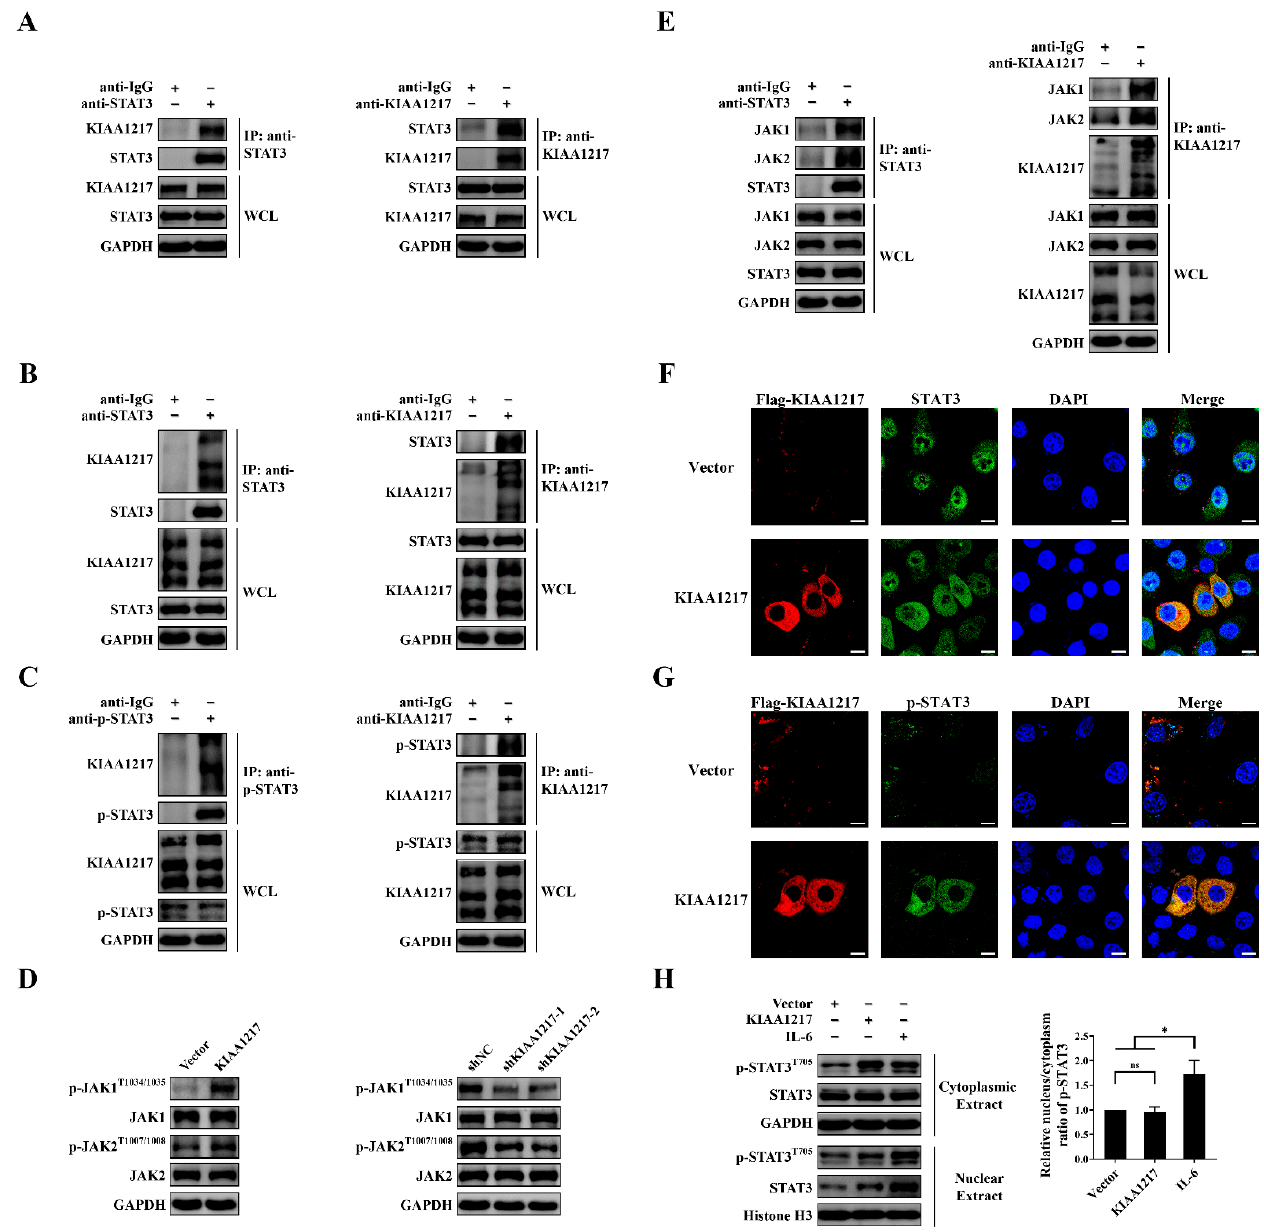
Figure 7. The interaction of KIAA1217 with STAT3/p-STAT3 and JAK1/2 in HCC cells. ( A – C ) Co-IP analysis of KIAA1217 and STAT3/p-STAT3 in HEK-293T cells ectopically expressing KIAA1217 and STAT3 ( A ) or in HepG2 cells ( B , C ). Isotype-matched IgG was used as a negative control. ( D ) Western blot analysis of the levels of JAK1/2 and p-JAK1/2 in HepG2 cells with KIAA1217 overexpression or knockdown. ( E ) Co-IP analysis of JAK1/2 with KIAA1217 or STAT3 in HepG2 cells. Isotype-matched IgG was used as a negative control. ( F , G ) Representative images of double IF staining for KIAA1217 (red) and STAT3 ( F )/p-STAT3 ( G ) (green) captured with a laser scanning confocal microscope. The nucleus was stained with DAPI (blue). The assay was performed in HepG2 cells overexpressing KIAA1217. Magnification ×1000; scale bars: 10 μ m. ( H ) Left panel, The cytoplasmic or nucleic STAT3/p-STAT3 levels in HepG2 cells overexpressing KIAA1217 or treated with IL-6 were detected using Western blot; right panel, quantitative evaluation of the Western blot results. ns: not significant; * p < 0.05. Error bars: SEM. GAPDH and Histone H3 were used as loading controls.